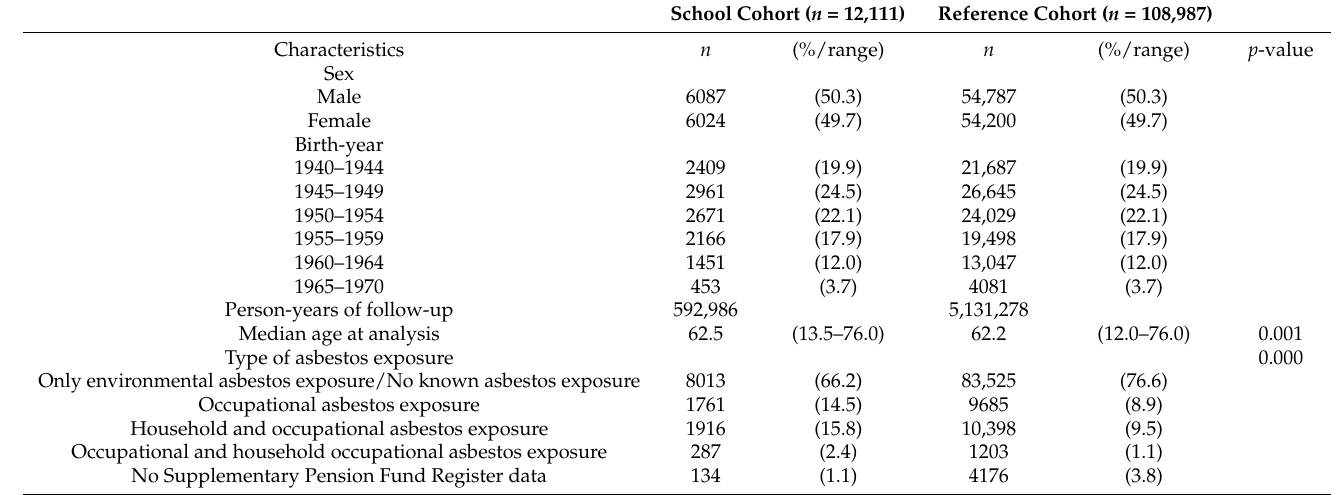
Table 1. Characteristics of the Aalborg School Children Cohort and the sex and age-matched refer- ence